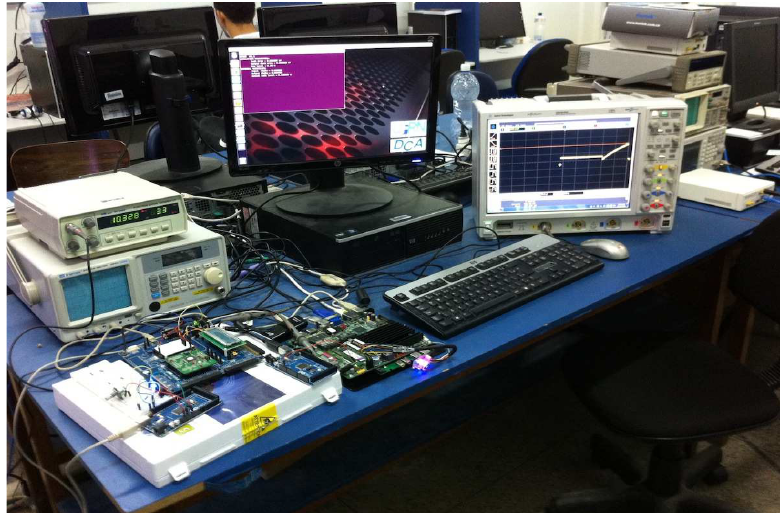
Figure 12. Equipment used to perform the experimental